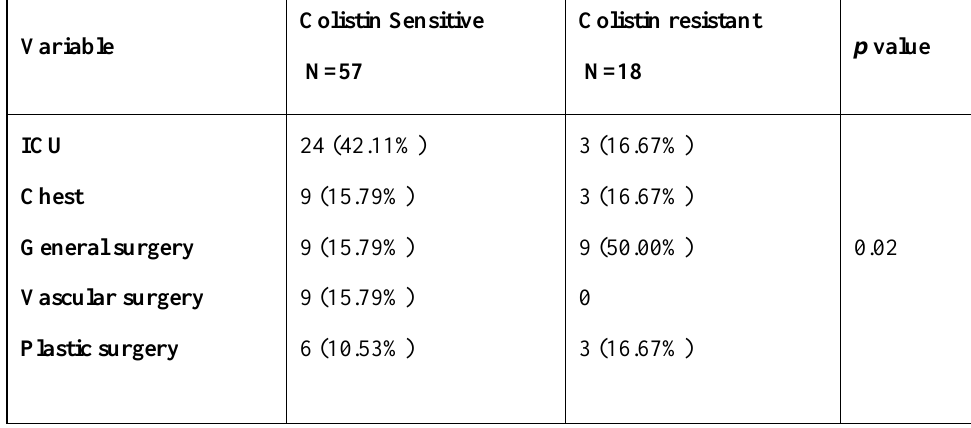
Table 6. Distribution of colistin resistant and colistin sensitive strains among different departments